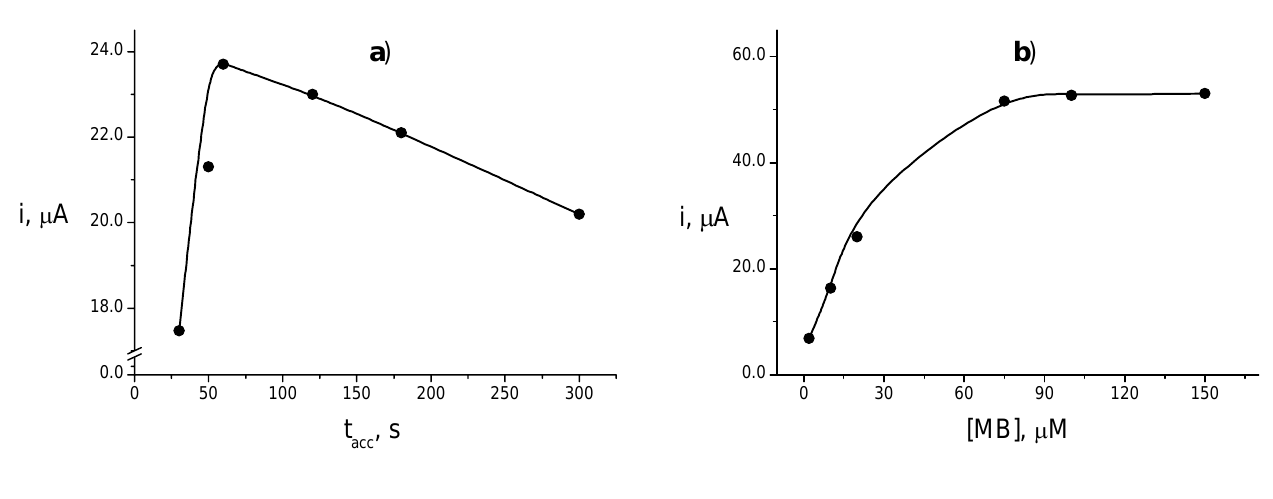
Figure 3. Effect of the accumulation time (a) and MB concentration (b) on the MB anodic stripping SW peak current at the ss-DNA-EDC/NHSS-MPA-AuE. Supporting electrolyte: 50 mM Tris-HCl, 20 = 1 min (b), open circuit. mM NaCl (pH 7.2). Accumulation conditions: [MB] = 20 µ M (a), t acc Measurement conditions: SWV, E = 30 mV, f = 100 Hz, v = 500 mV s -1 sw